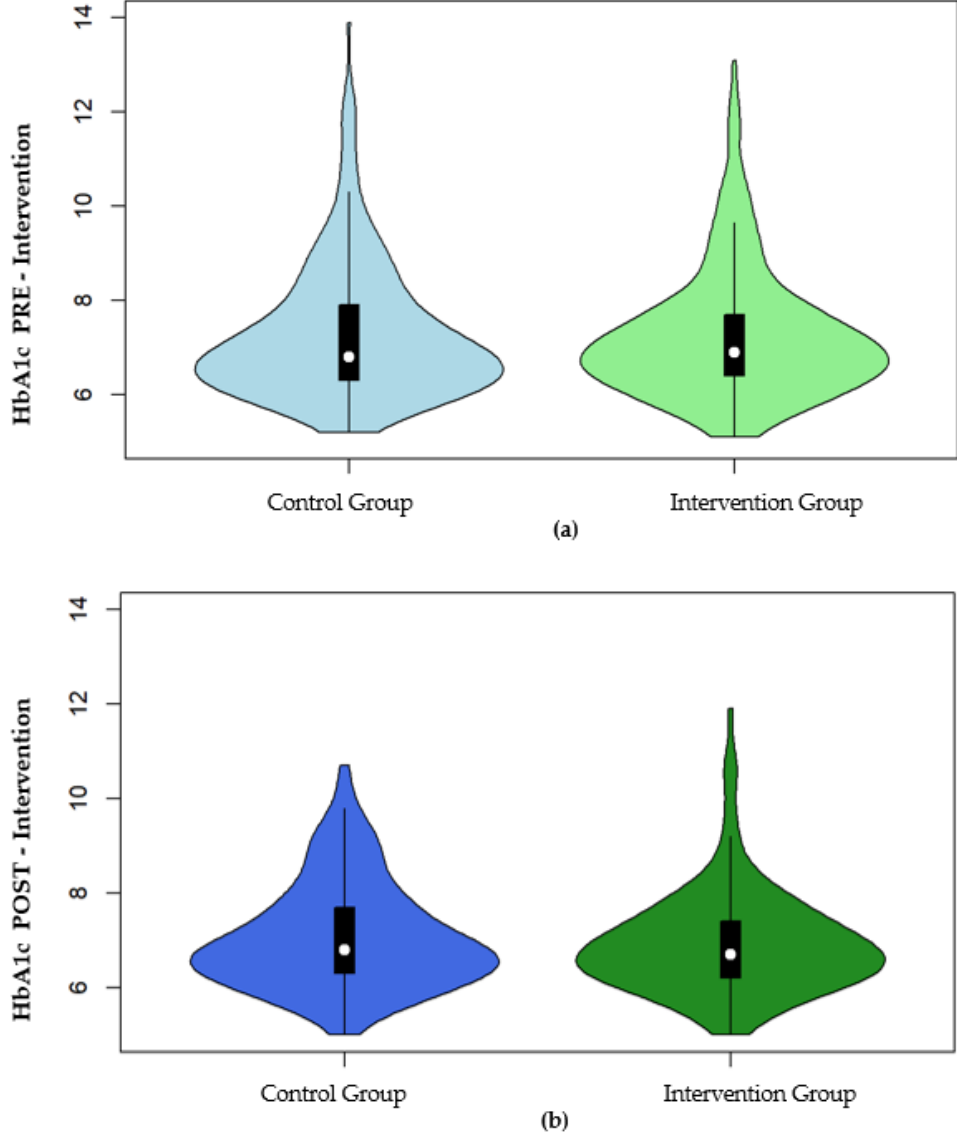
Figure 2. ( a ) HbA1c pre-intervention; ( b ) HbA1c post-intervention.